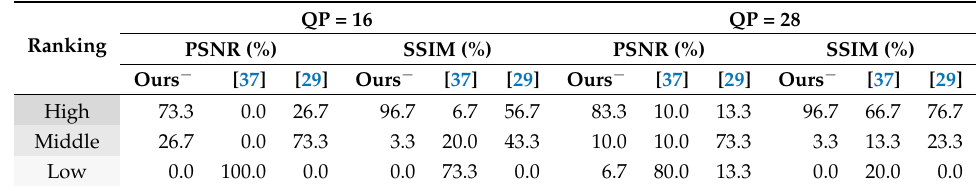
Table 7. The percentages of PSNR and SSIM values of different schemes without using the ( 0,0 ) coefficient pairs in each ranking.